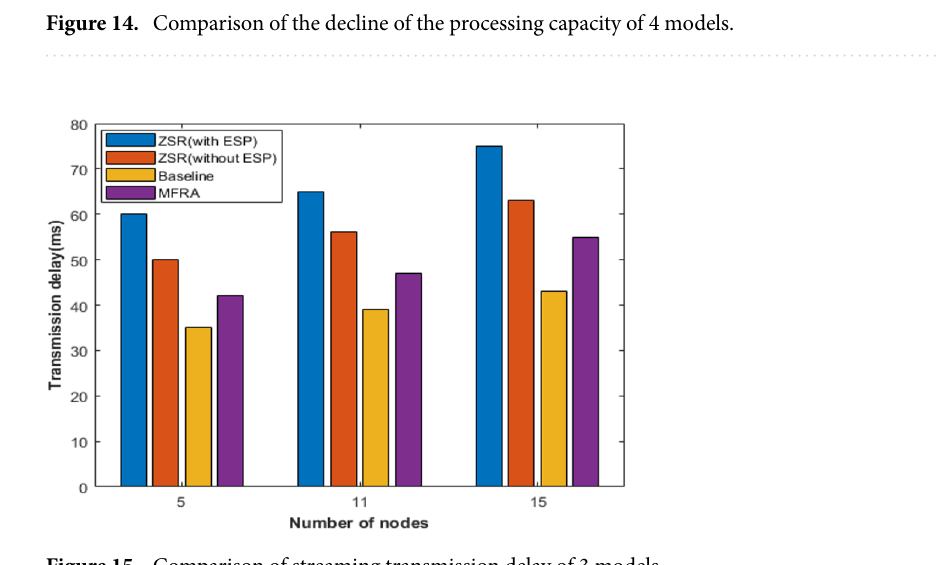
Figure 15. Comparison of streaming transmission delay of 3